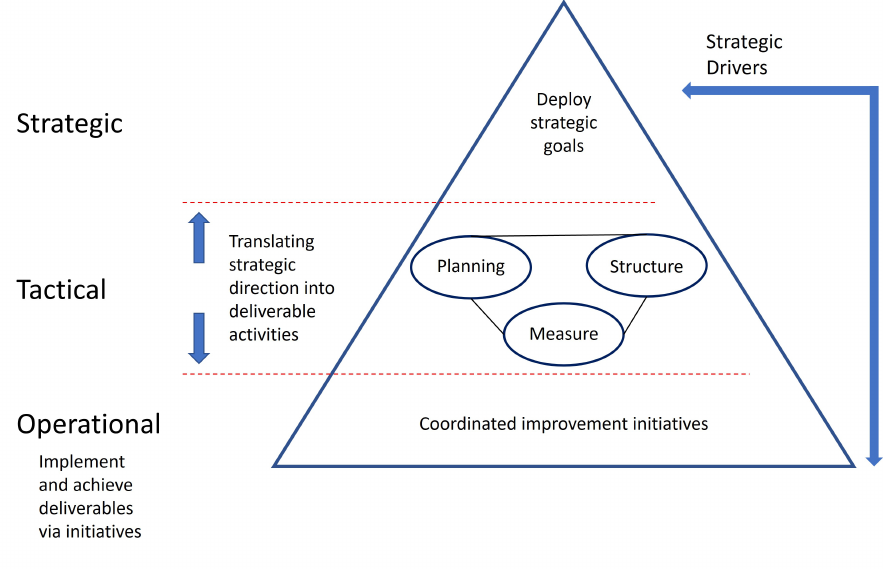
Figure 1. The management pyramid (source: ref. [43]).